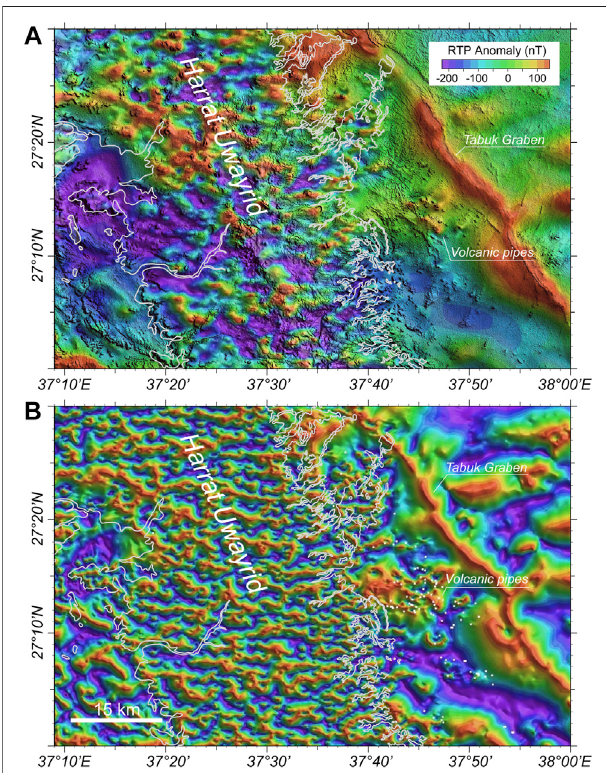
FIGURE 4 | (A) Reduced-to-the pole (RTP) magnetic anomalies superimposed on the topographic relief of the study area. (B) Tilt derivative of the RTP grid to highlight small local anomalies. White dots indicate pipe locations. The original 100 m grid in UTM Zone 37 coordinates was re- projected in a Mercator projection at 27 ° N, datum